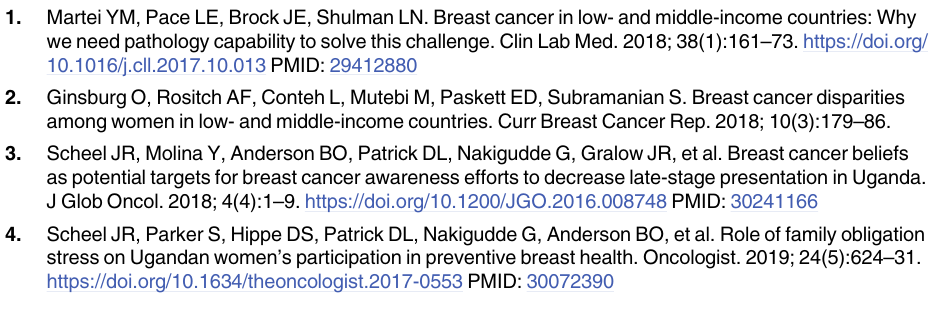
S1 Table. Population characteristics of symptomatic women presenting for a breast evalua- tion (N = 171). S2 Table. Accuracy of PCP assessment in detecting cancers, by actual and potential report- ing system (N =